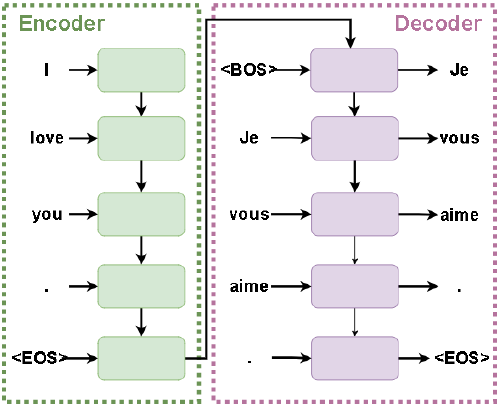
Figure 4. Seq2seq learning with an RNN encoder and decoder